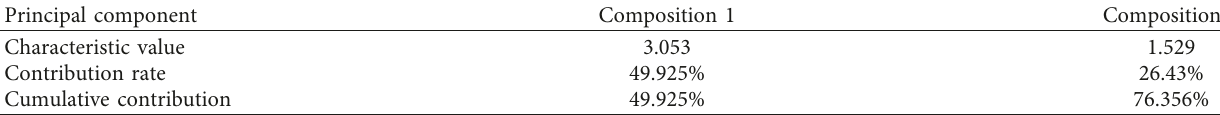
Table 5: The eigenvalue and variance contribution of the principal component.